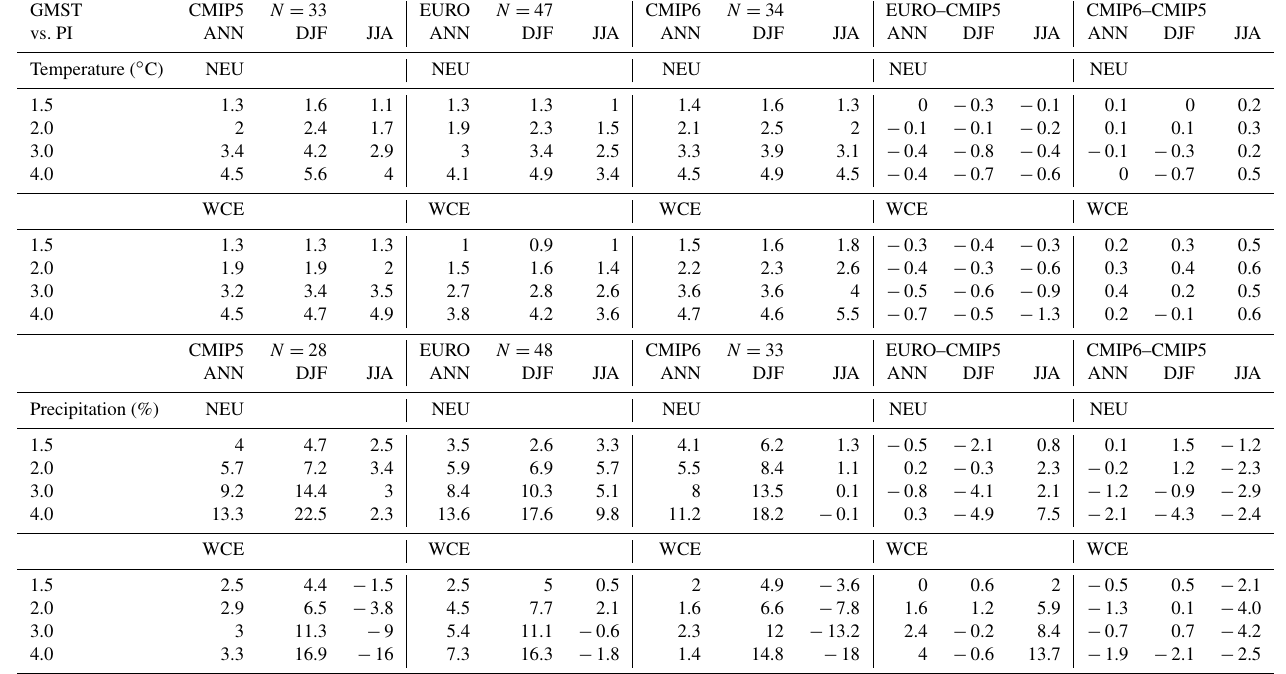
Table 8. As in Table 6, with ensemble mean changes in temperature (degrees Celsius) and precipitation (percent) at selected future global mean surface temperature (GMST) levels (1.5 to 4.0 ◦ C) compared to preindustrial (PI) conditions during 1986–2005. In addition to CMIP5 and CMIP6, EURO-CORDEX ensemble mean scenario simulations are also shown. Note that the regional climate models of EURO- CORDEX are driven by different ESMs than the presented ESMs of the CMIP5 ensemble.